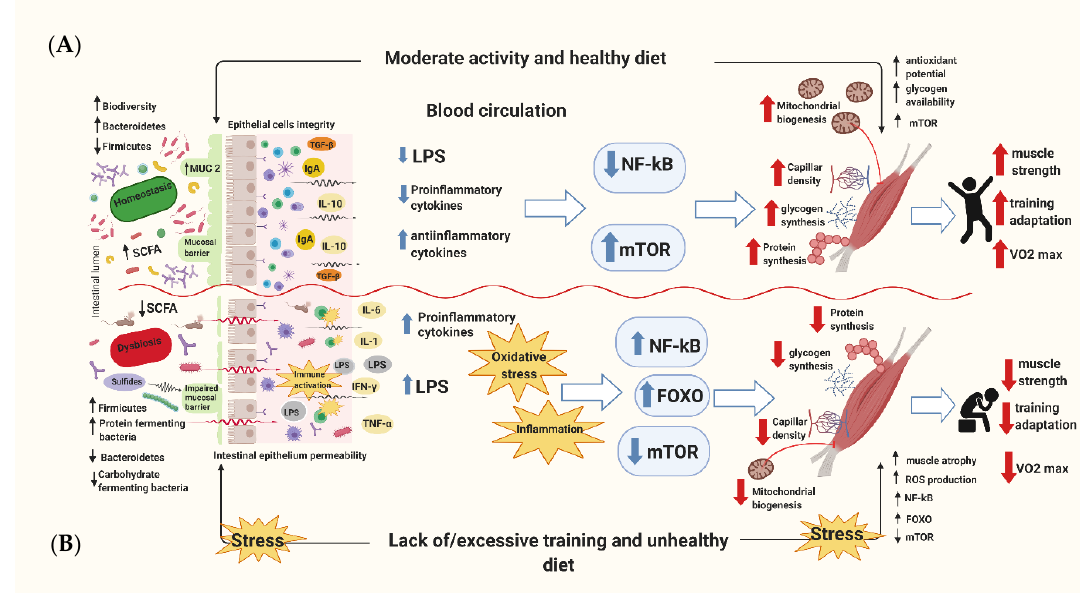
Figure 1. The schematic diagram of combined healthy/unhealthy diet and exercise/lack of exercise action on human skeletal muscle. ( A ) A properly balanced diet and systematic moderate exercise show both direct and indirect effects to benefit skeletal muscle function by reducing oxidative stress and inflammation status. As a result, this shifts to the higher muscle glycogen storage and increased mitochondrial biogenesis and function, as well as the predominance of anabolic signaling pathways, which increasethe aerobic exercise capacity. ( B ) The opposite effects are observed in the case of an inadequately balanced diet and insufficient or excessive physical effort. This leads to an increase in inflammatory and oxidative stress markers, a decrease in the ability to store muscle glycogen and a reduction of mitochondria function, as well as muscle atrophy and the higher accumulation of body fat.